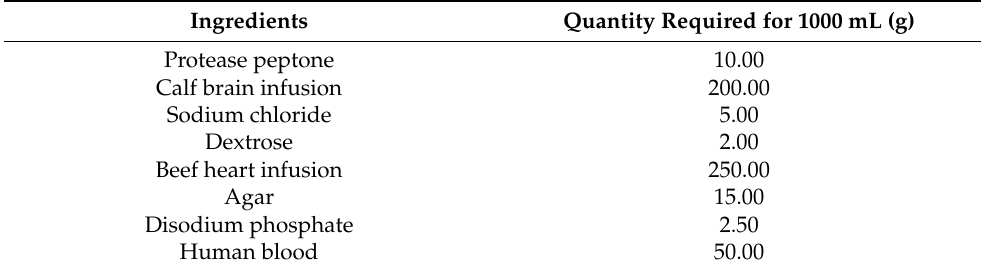
Table 7. Brain heart infusion agar (BHIA) medium composition